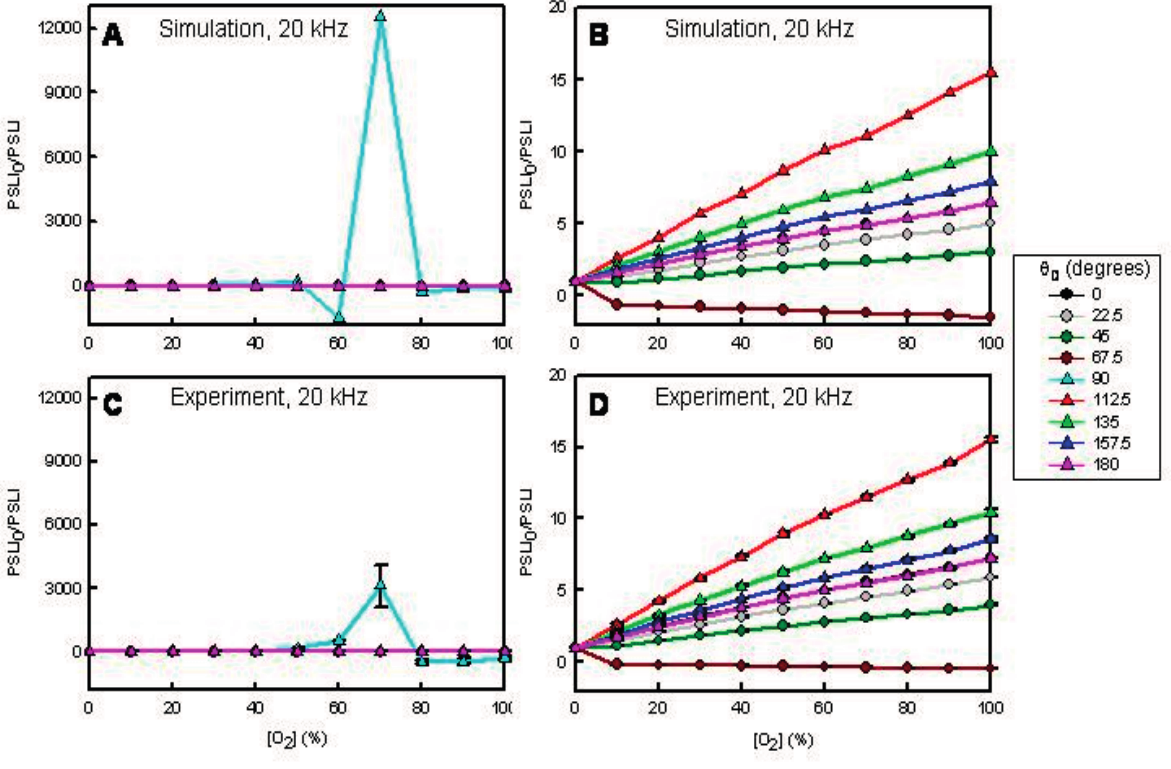
Figure 4. Simulated ( A , B ) and experimental ( C , D ) O 2 -dependent, phase sensitive Stern-Volmer plots for a [Ru(dpp) 3 ] 2+ -doped C8-TEOS/TEOS-based xerogel film at f = 20 kHz. In the simulations τ 0 = 5.0 μ s and K SV = 0.1 O 2 % − 1 . ( B , D ) θ D = 90° data